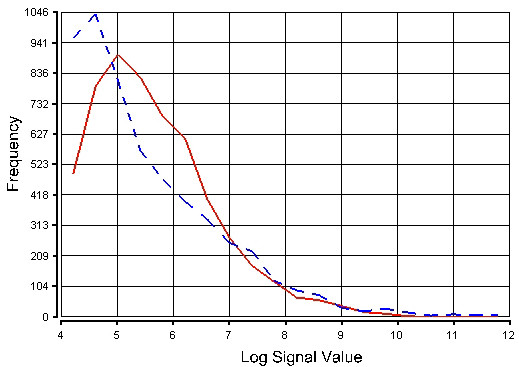
Frequencies of signal values from the Exon and U133 Plus 2 Arrays. The distribution of log2 (signal + 16) values of transcript clusters are shown for the Exon Array (solid line) and the U133 Plus 2 Array (stippled line) for breast tissues.